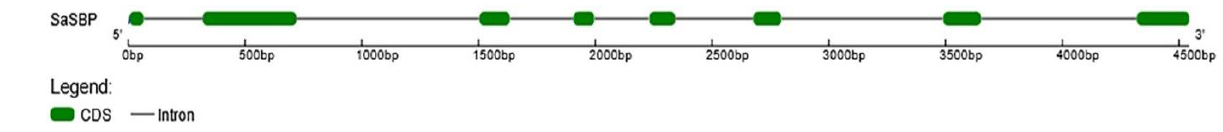
Figure 4. Structures of SaSBP gene.